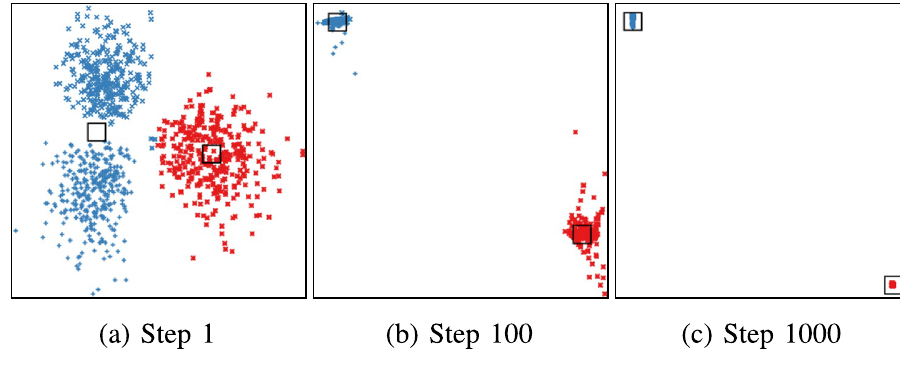
Fig. 2 The plots illustrate the deficiencies of the compression loss without projection. The data point colors represent leaf node assignments. We can see that orthogonal information is destroyed. Therefore, splitting one of the leaf nodes would not result in sufficiently large mar- gins between the two potential leaf